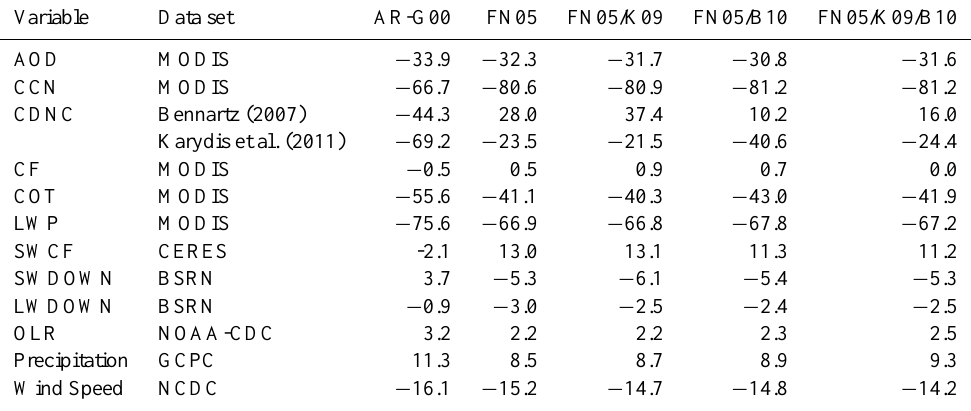
Table 2. Annual mean normalized mean biases (NMBs, in %) of the CESM-CAM5-predicted meteorological/radiative variables. Variable